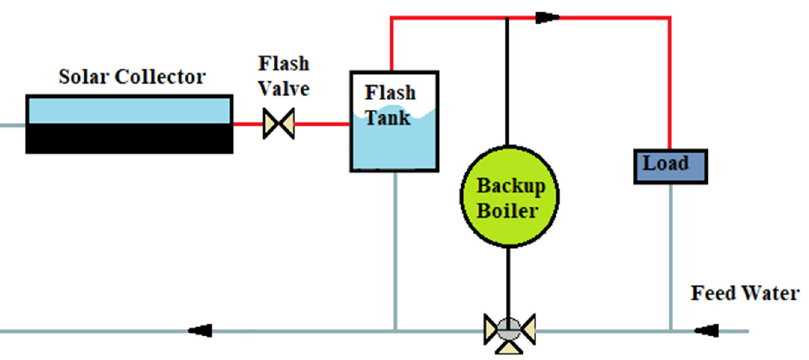
Figure 7. Indirect steam generation system with flash boiler without backup. Adapted from Ref. [44], Copyright (1985), with permission from Elsevier.